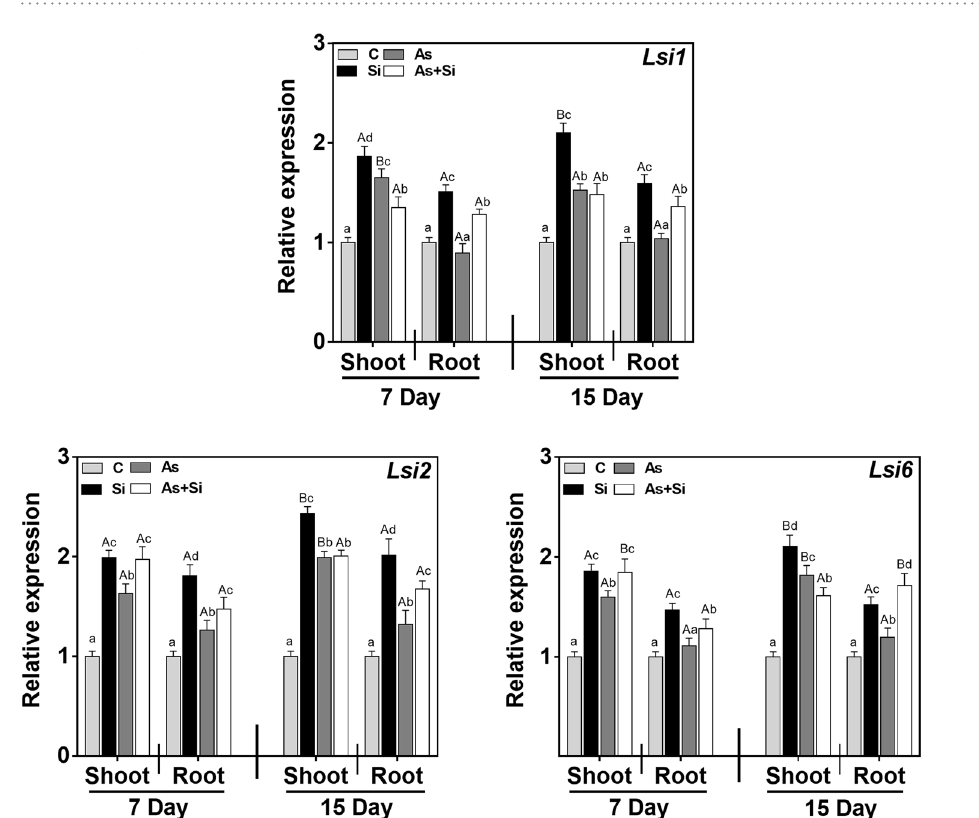
Figure 2. Effect of Si, As (III) , and As (III) + Si on the relative expression of Si transporter ( Lsi1 , Lsi2 and Lsi6 ) in shoot and root of Oryza sativa var. IR64 at 7 and 15 d. All values are means of three replicates (n = 3, ± SD) and repeated twice. Different letters indicate the significant mean difference ( p < 0.05) between each treatment. The small latter (i.e. a, b, c and d) indicates the significant difference between treatment in same tissue type while capital latter (i.e. A and B) indicates the significant difference between duration among the same treatment in same tissue type. The endogenous actin gene of rice was used to normalize the genes relative to